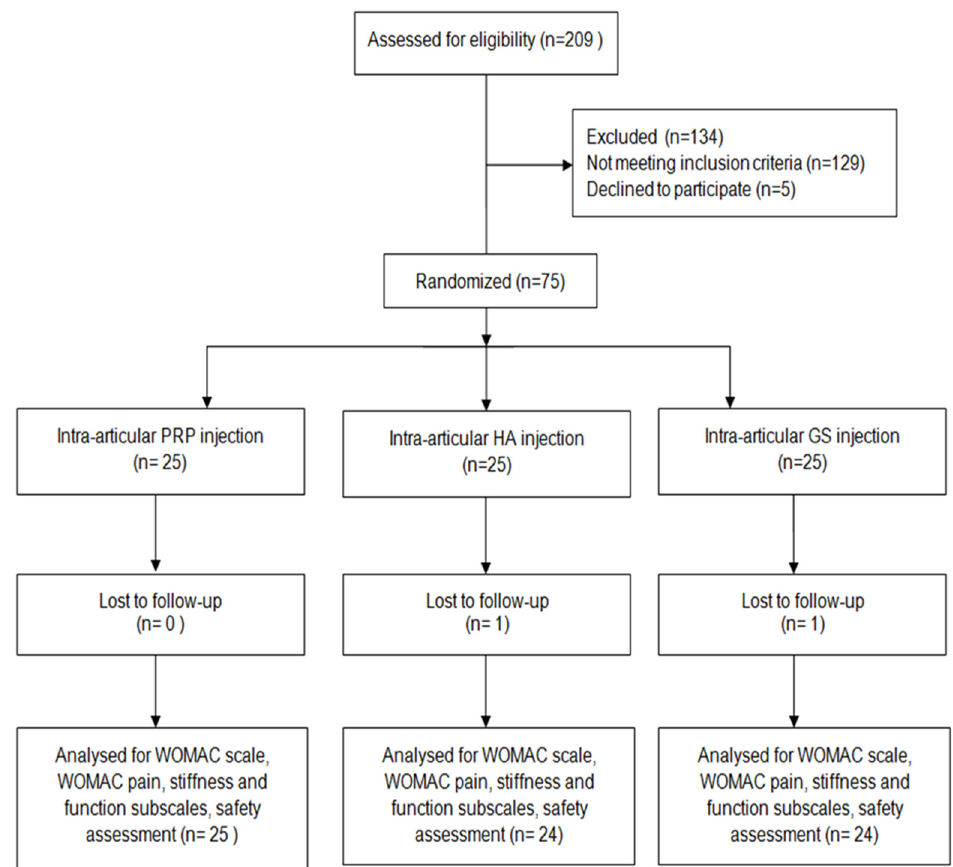
Figure 1. The CONSORT flow diagram of the trial.